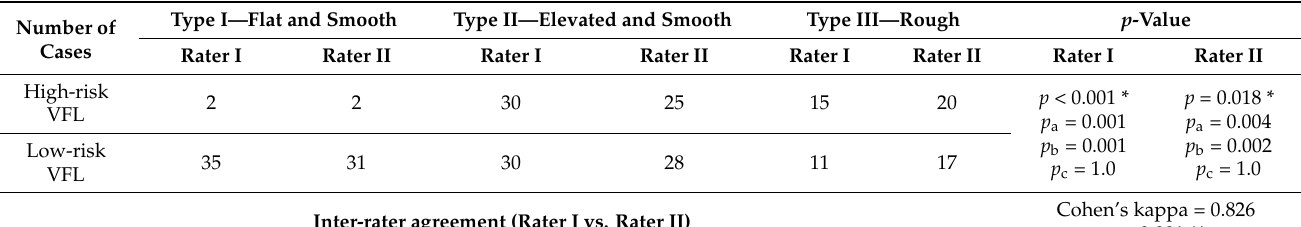
Table 2. Videolaryngoendoscopy classification of vocal fold leukoplakia according to Rater I and Rater II.